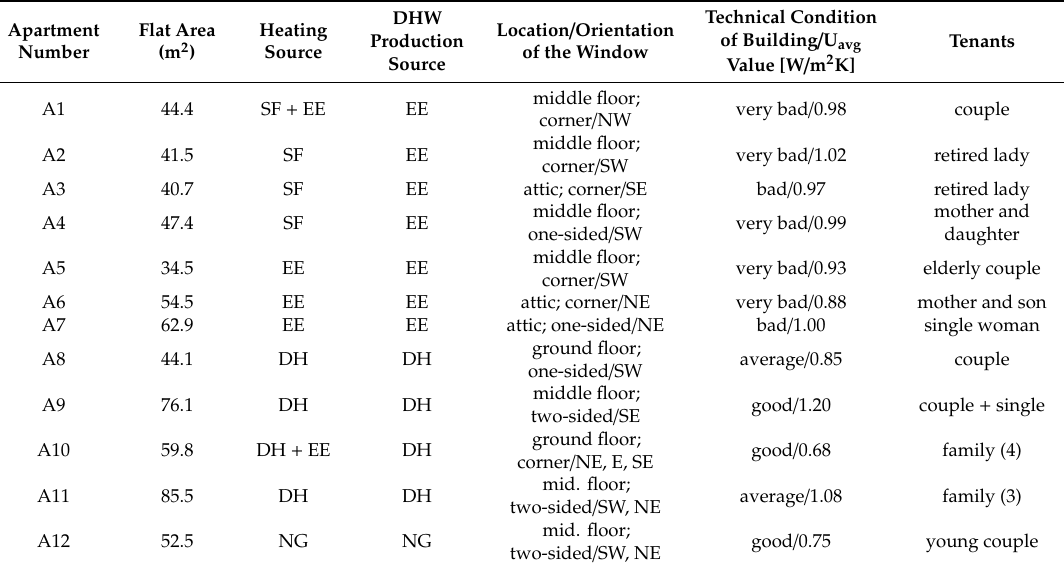
Table 1. Basic information about the